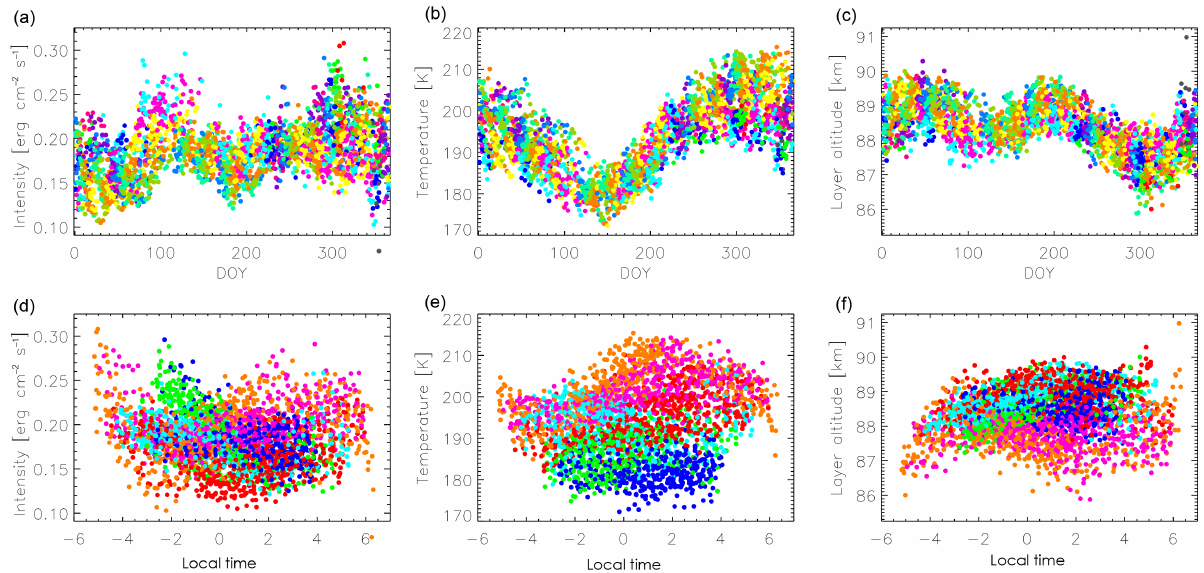
Figure 2. SABER OH intensity (a, d) , equivalent temperature (b, e) and layer altitude (c, f) variations with the day of the year (a, b, c) and the solar local time (d, e, f) . Colors correspond to local solar time (a) – (c) and to months of the year (d) – (f) (red: JF, green: MA, dark blue: MJ, light blue: JA, pink: SO, orange: